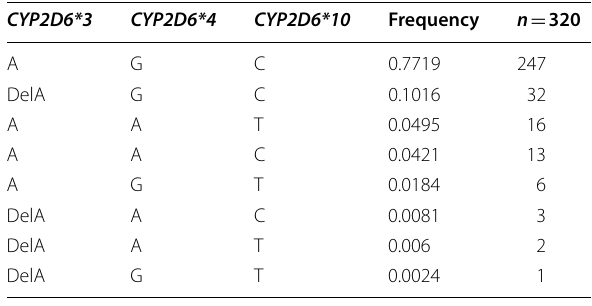
and allelic frequencies of CYP2D6 polymorphisms in the Moroccan population